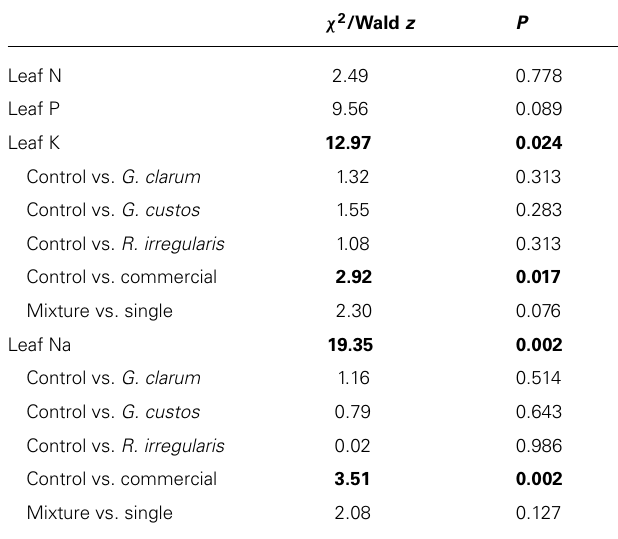
Table 2 | Results of GLMM analyses ofAMF treatment effects on leaf nutrient